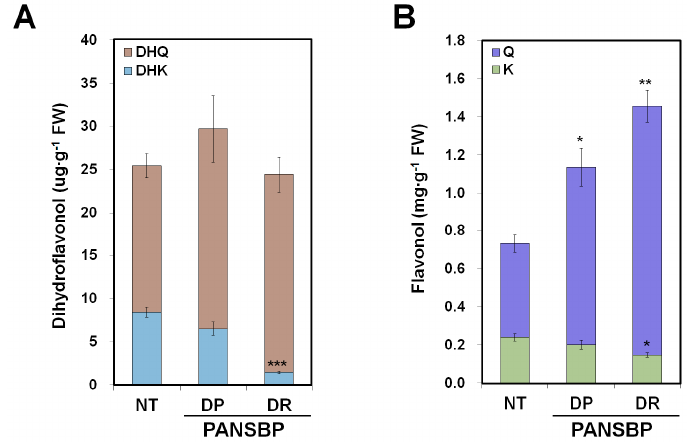
Figure 5. Analysis of dihydroflavonol and flavonol levels in the petals of non-transformed (NT) and PANSBP transgenic tobacco. ( A ) Dihydroflavonol levels in NT and transgenic lines (DHQ, dihydroquercetin; DHK, dihydrokaempferol). ( B ) Flavonols levels in NT and transgenic lines (Q, quercetin; K, kaempferol). All results represent mean values ± SD from three biological replicates. *, ** and *** indicate values that differ significantly from NT at p < 0.05, p < 0.01 and at p < 0.001, respectively, according to a Student’s paired t -test.